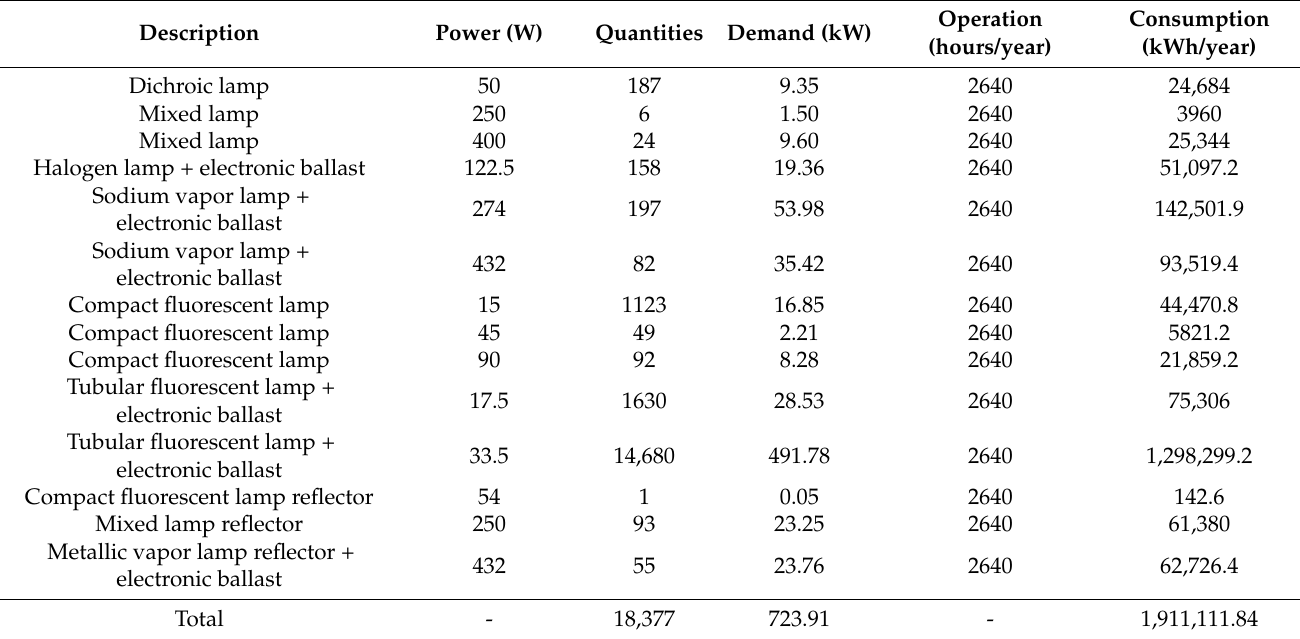
Figure 4. Type and Power of Lamps. Table 5. Existing Lighting